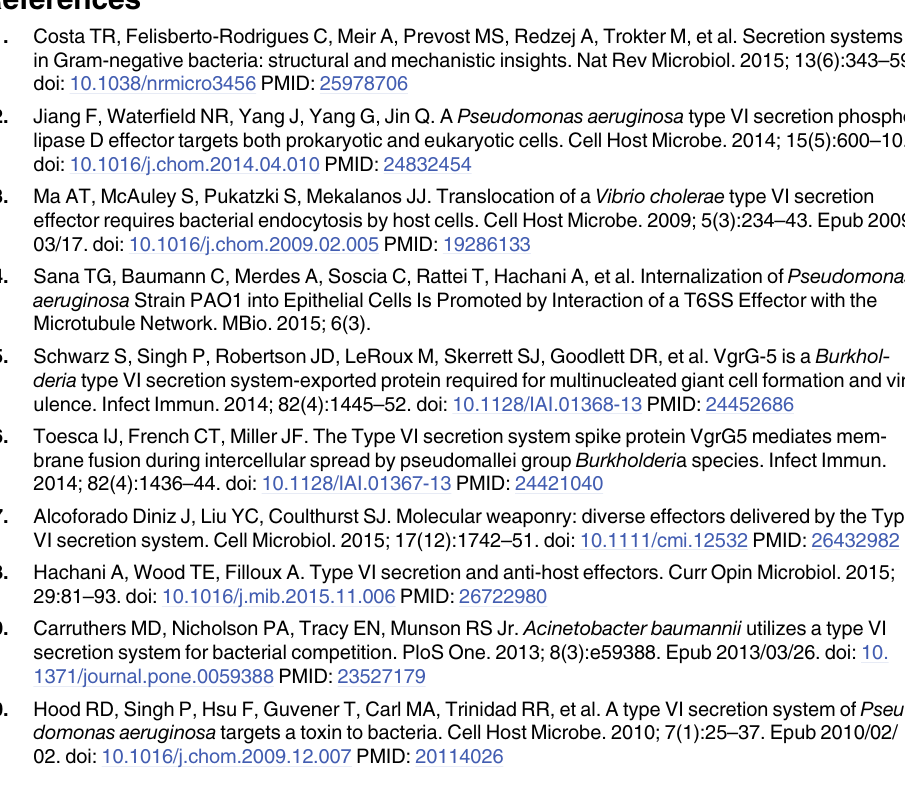
S2 Table. Oligonucleotide primers for plasmid